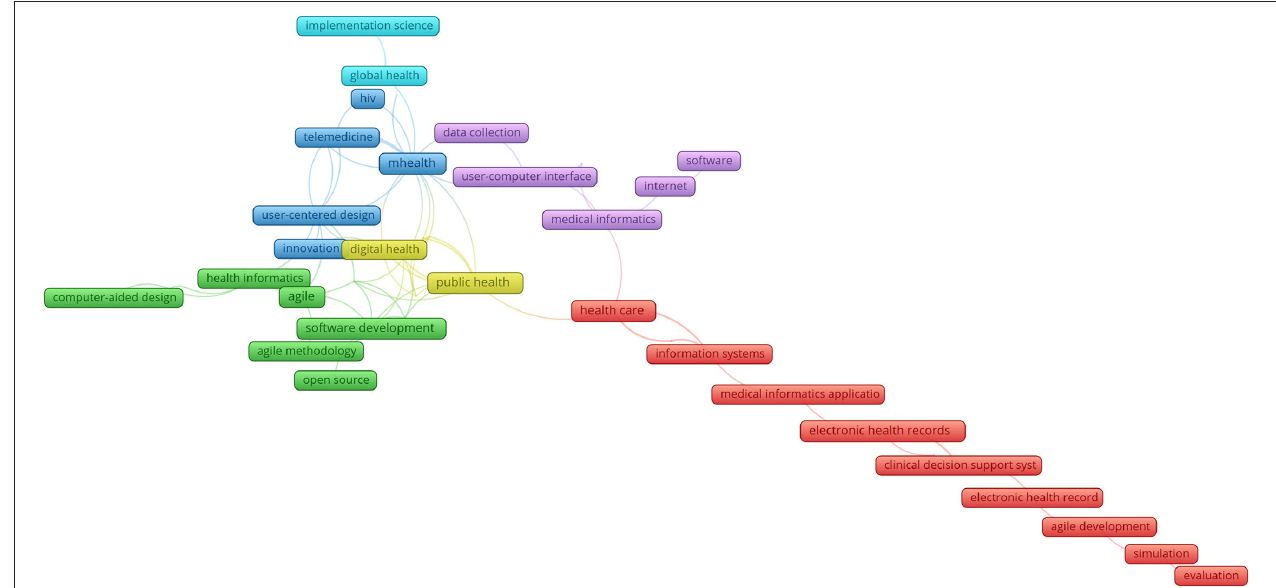
FIGURE 1 | Agile software development (ASD) uses digital health software (DHSW)